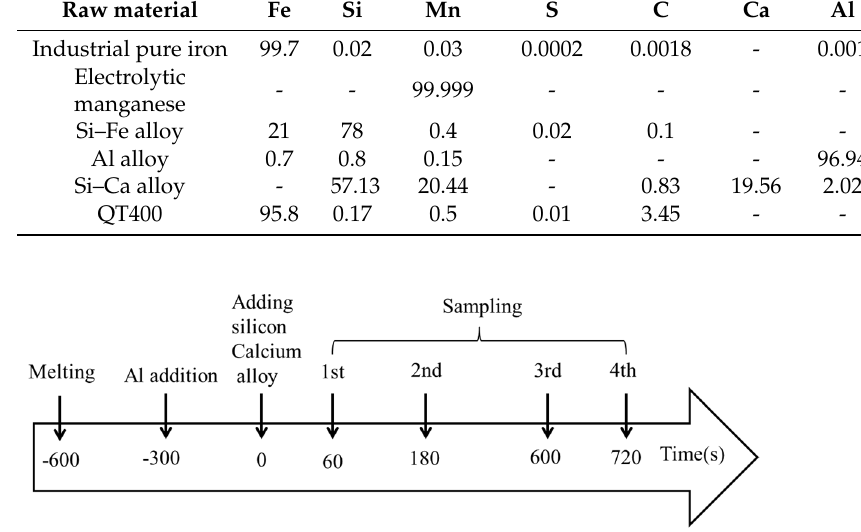
Table 2. Chemical compositions of steels used in different experiments (mass%).